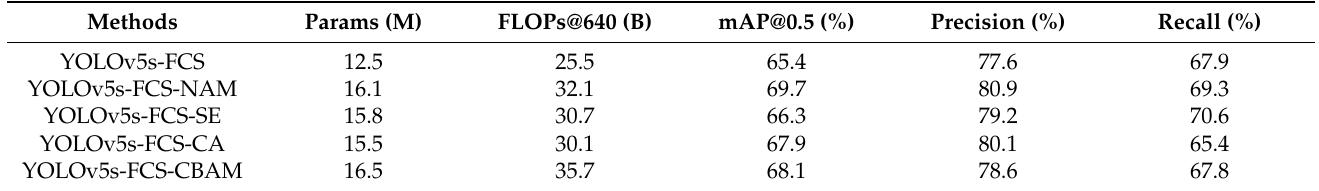
Table 3. Comparative experiments of different attention mechanisms on MS COCO datasets.